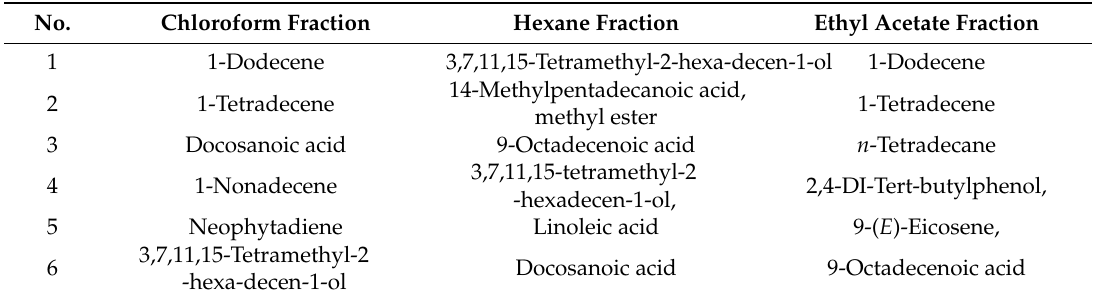
Table 3. Phytochemicals present in chloroform, hexane and ethyl acetate fractions of Rhododendron arboreum